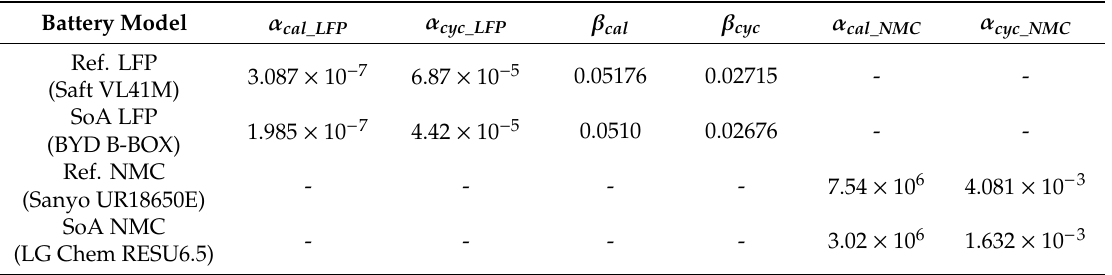
Table 1. Calendar and Cycling Aging Models’ Coe ffi cients for the di ff erent Battery Types analyzed. Battery